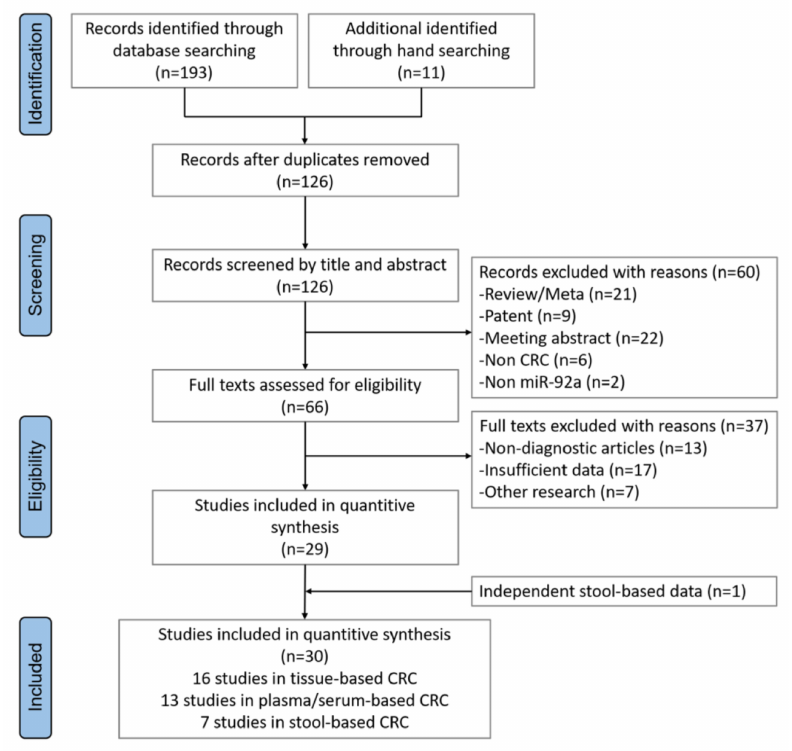
Figure 1. Study selection for miR-92a test in colorectal cancer